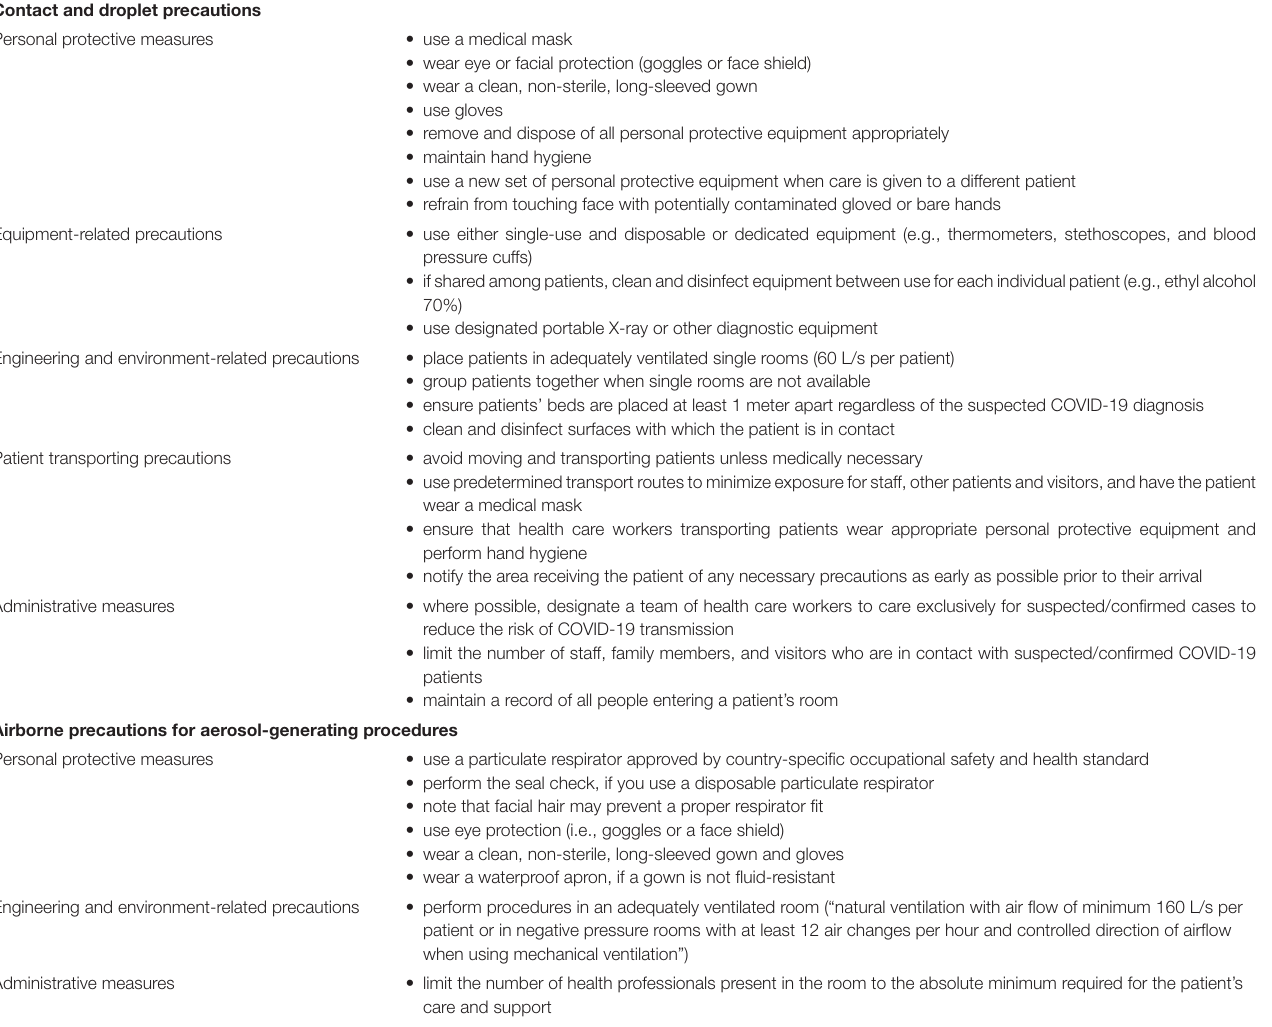
TABLE 1 | COVID-19 patient care: Empiric additional precautions*. Contact and droplet